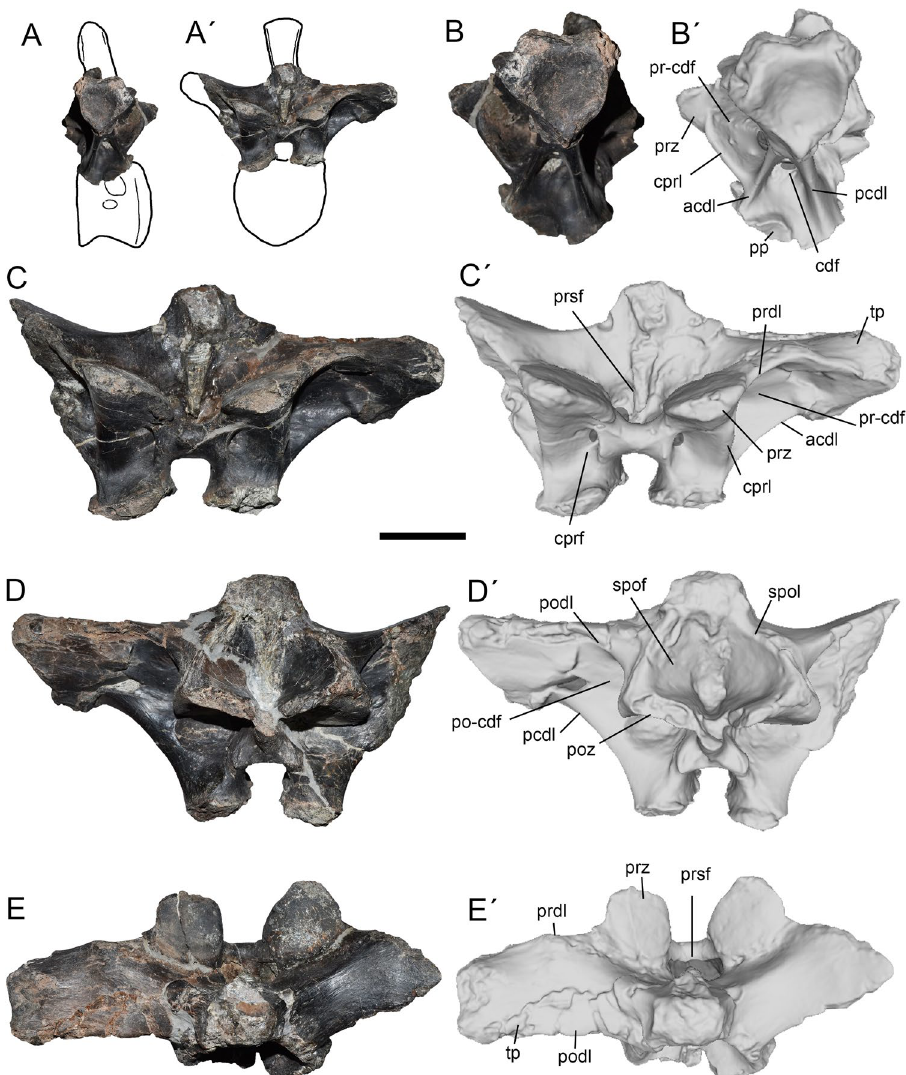
Figure 3. Second dorsal of Maip . Interpretative drawing showing the preserved parts of the bone ( A , A´ ) and lateral ( B , B´ ), anterior ( C , C´ ), posterior ( D , D´ ) and dorsal ( E , E´ ) views. Scale bar: 5 cm. Abbreviations: acdl; anterior centrodiapophyseal lamina; cdf; centrodiapophyseal fossa; cprf; centroprezygapophyseal fossa; cprl; centroprezygapophyseal lamina; pcdl; posterior centrodiapophyseal lamina; podl; postzygapophyseal lamina; poz, postzygapophyses; po-cdf; postzygapophyseal-centrodiapophyseal fossa; pp, parapophyses; prdl; prezygodiapophyseal lamina; prsf; prespinal fossa; prz, prezygapophyses; pr-cdf; prezygapophyseal- centrodiapophyseal fossa; spof; spinopostzygapophyseal fossa; spol; spinopostzygapophyseal lamina; tp, transverse